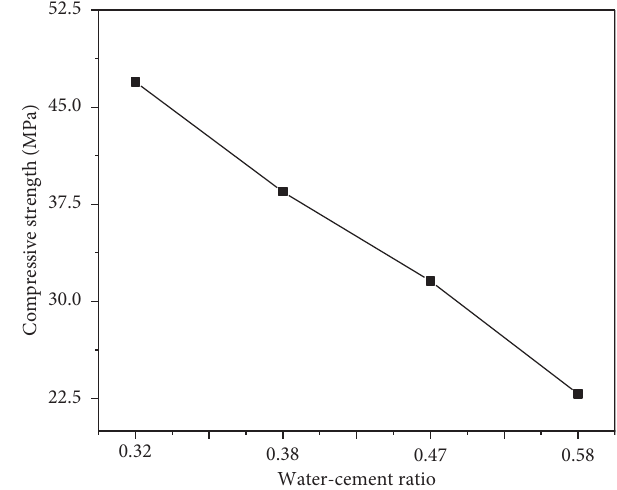
Figure 8: The impact of the water-cement ratio on the compressive strength of the FSSAC.